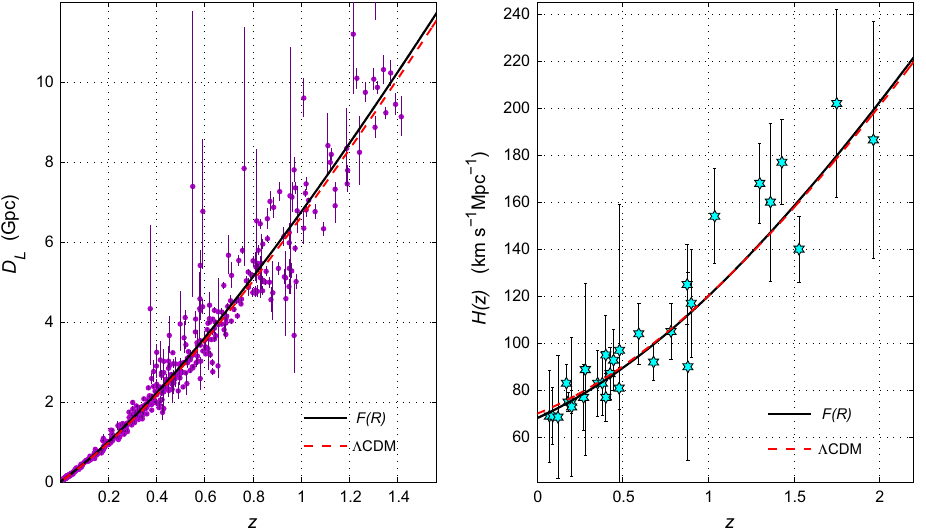
Fig. 5 Luminosity distance (left panel) and Hubble parameter (right panel) for the best fit when considering the general case described by (3.7) for the model (3.1). The best fit for (cid:2) CDM is also depicted